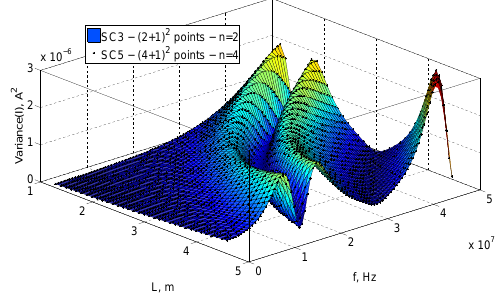
Figure 4: Variance( I ) from SC3 and SC5.